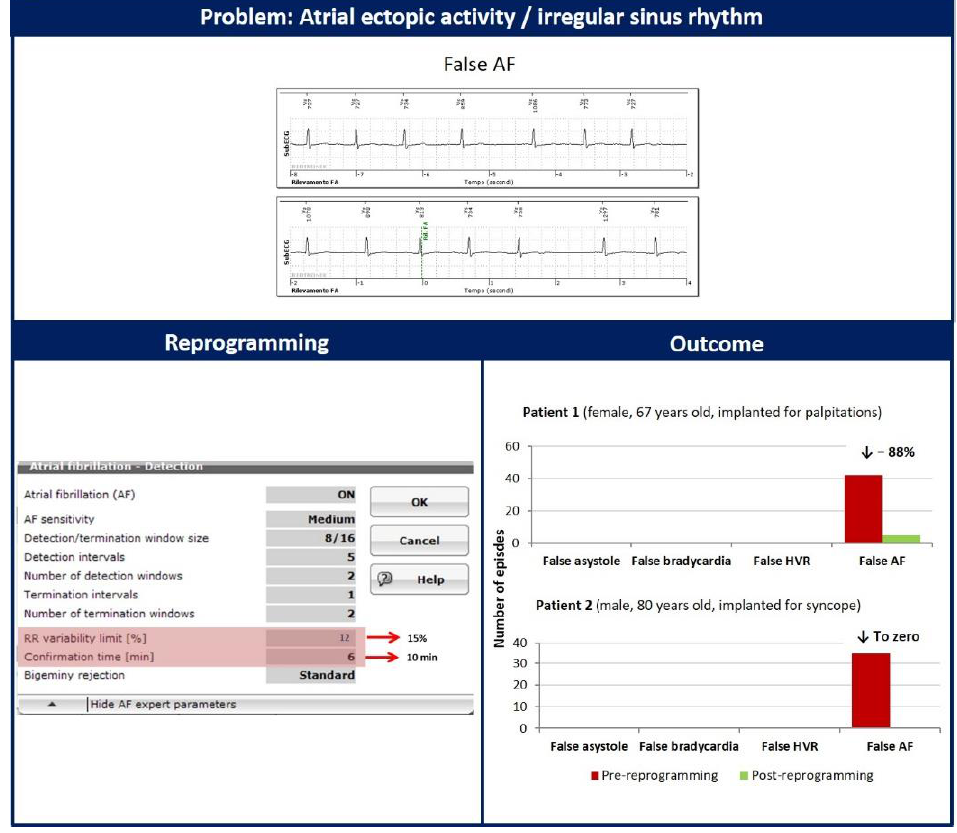
Figure 3. The presence of ectopic atrial activity or irregular sinus rhythm can cause false episodes of atrial fibrillation (AF). We increased the R-R variability limit from 12% to 15% and the confirmation time from 6 to 10 min to solve this detection issue.